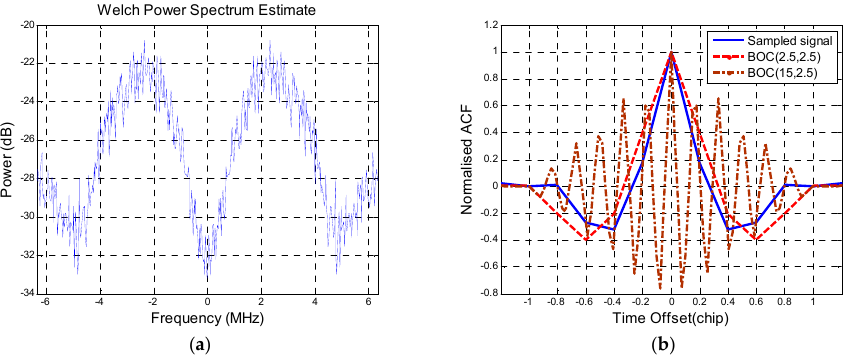
Figure 4. PSD (power spectrum density) and ACF (autocorrelation function) of the sample d BOC (binary offset carrier) signals. ( a ) PSD; ( b ) ACF.